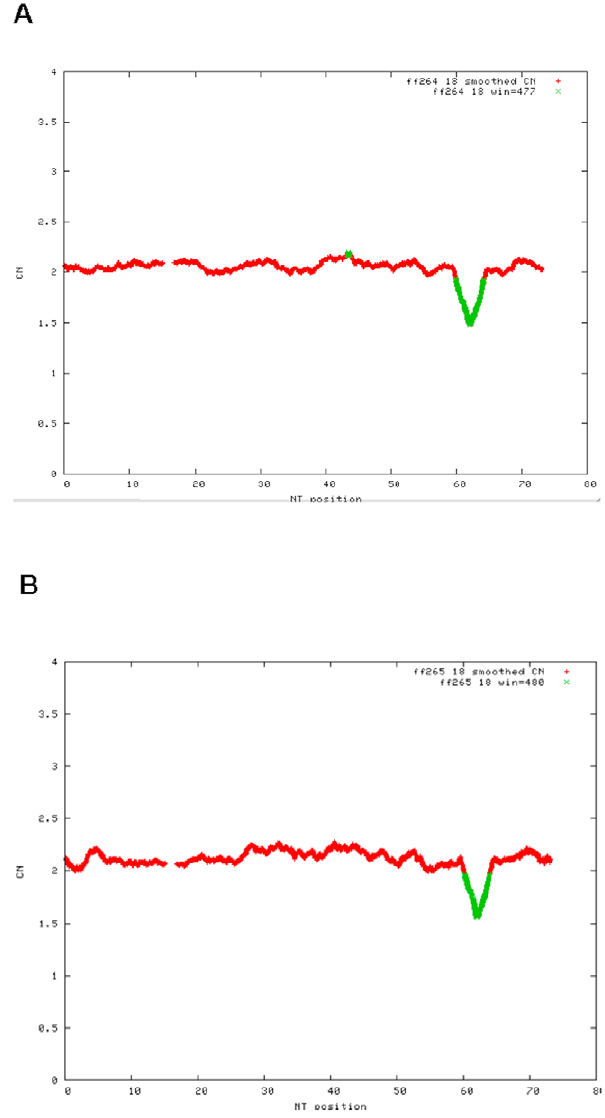
Figure 1. A 500K Microarray shows a 2.7 Mb deletion of 18q22.1 in the propositus. Fig. 1A. Graph of smoothed copy number for chromosome 18 from the Affymetrix 500K Array in the propositus, indicating loss of copy number (green color) and demonstrating a chromosome deletion at chromosome 18q22.1. The x-axis shows the nucleotide number from 1–76,117,153 on chromosome 18 and the y- axis shows smoothed copy number. Fig. 1B. Graph of smoothed copy number for chromosome 18 from the Affymetrix 500K Array in the mother of the propositus, indicating a similar loss of copy number (green color) at chromosome 18q22.1. The x-axis shows the nucleotide number from 1–76,117,153 on chromosome 18 and the y-axis shows smoothed copy